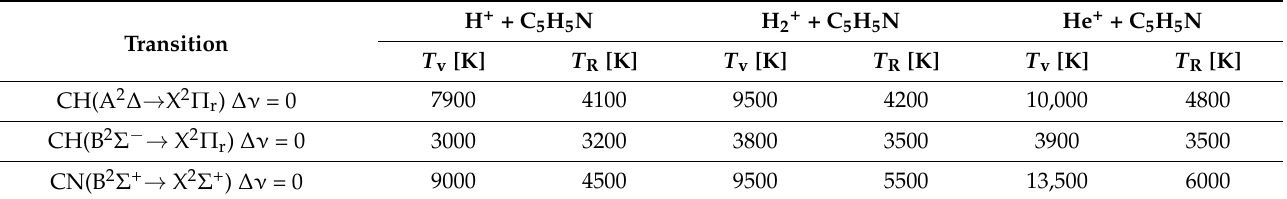
Figure 3. The experimental (black dots) and simulated (red contours) CN(B 2 Σ + → X 2 Σ + ) + CH(B 2 Σ + → X 2 Π r ) spectra obtained in the ( a ) H 2+ + pyridine (E = 1000 eV), ( b ) H + + pyridine (E = 1000 eV). Table 1. Characteristic vibrational ( T v ) and rotational ( T R ) temperatures obtained from the fittings. The data for He + + C 5 H 5 N collisions was taken from [32]. The uncertainties were 500 and 200 K for T v and T R in all impact systems,